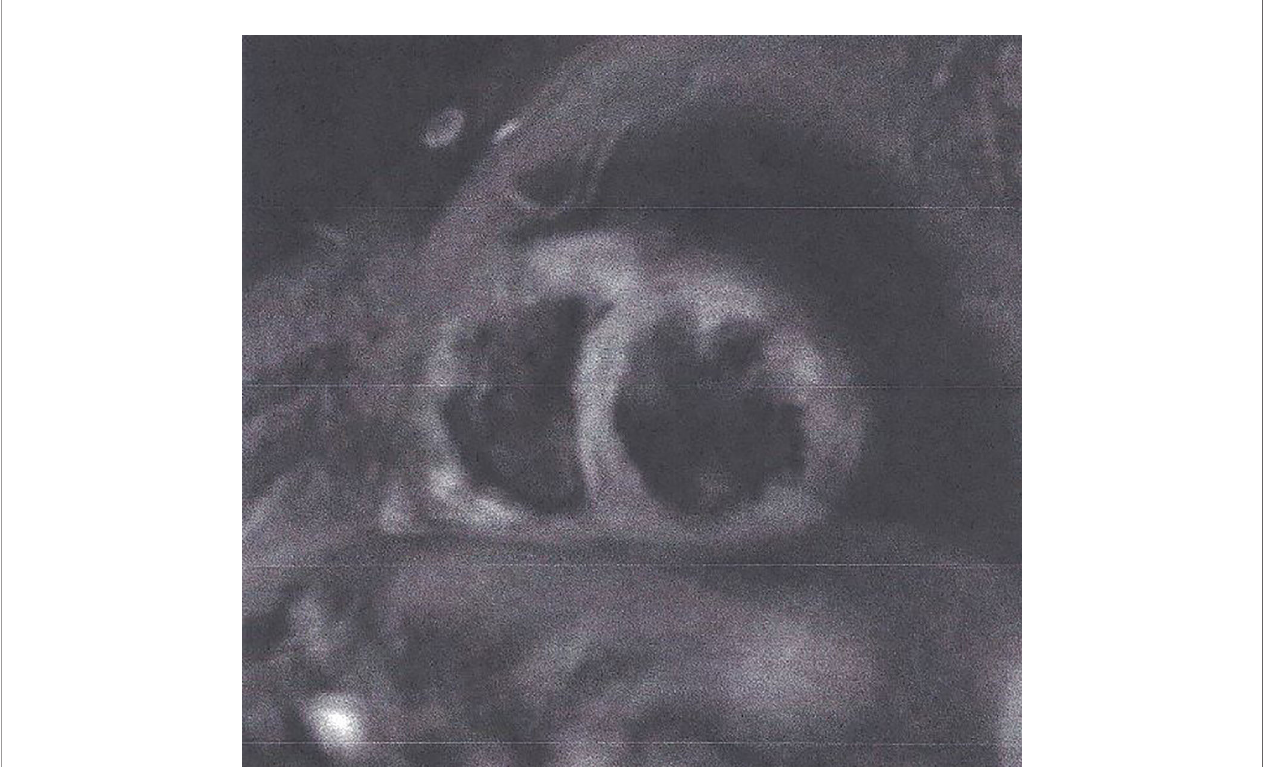
FIGURE 2 | STIR T2 image showing transmural oedema in myocardial infarction. This fi gure is original and based on data from Mavrogeni et al.